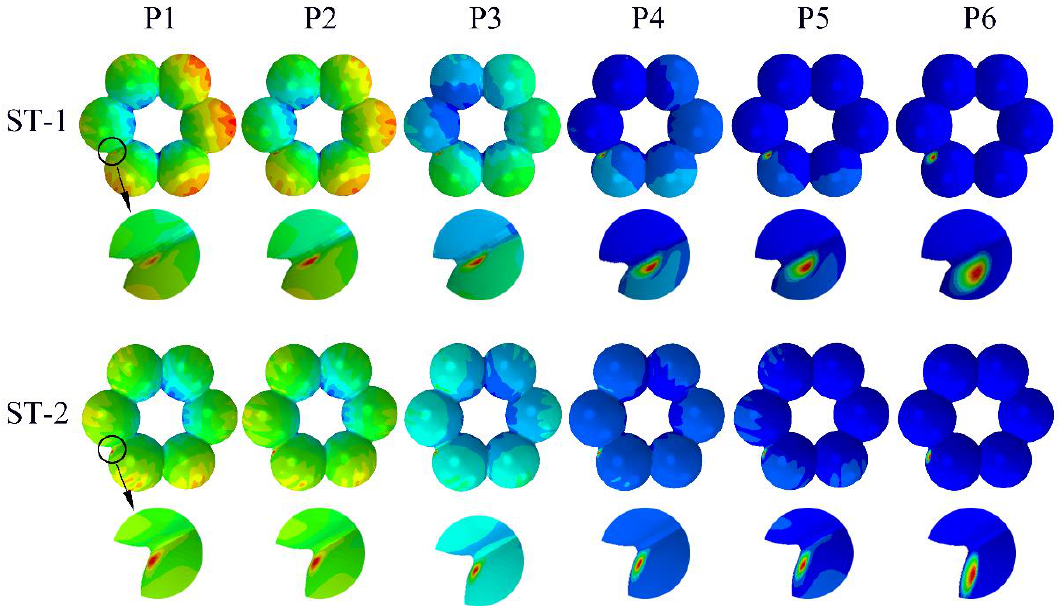
Figure 10. Deformation evolution of ST-1 and ST-2 sphere-segmented toroidal shells; six points correspond to those in Figure 9.